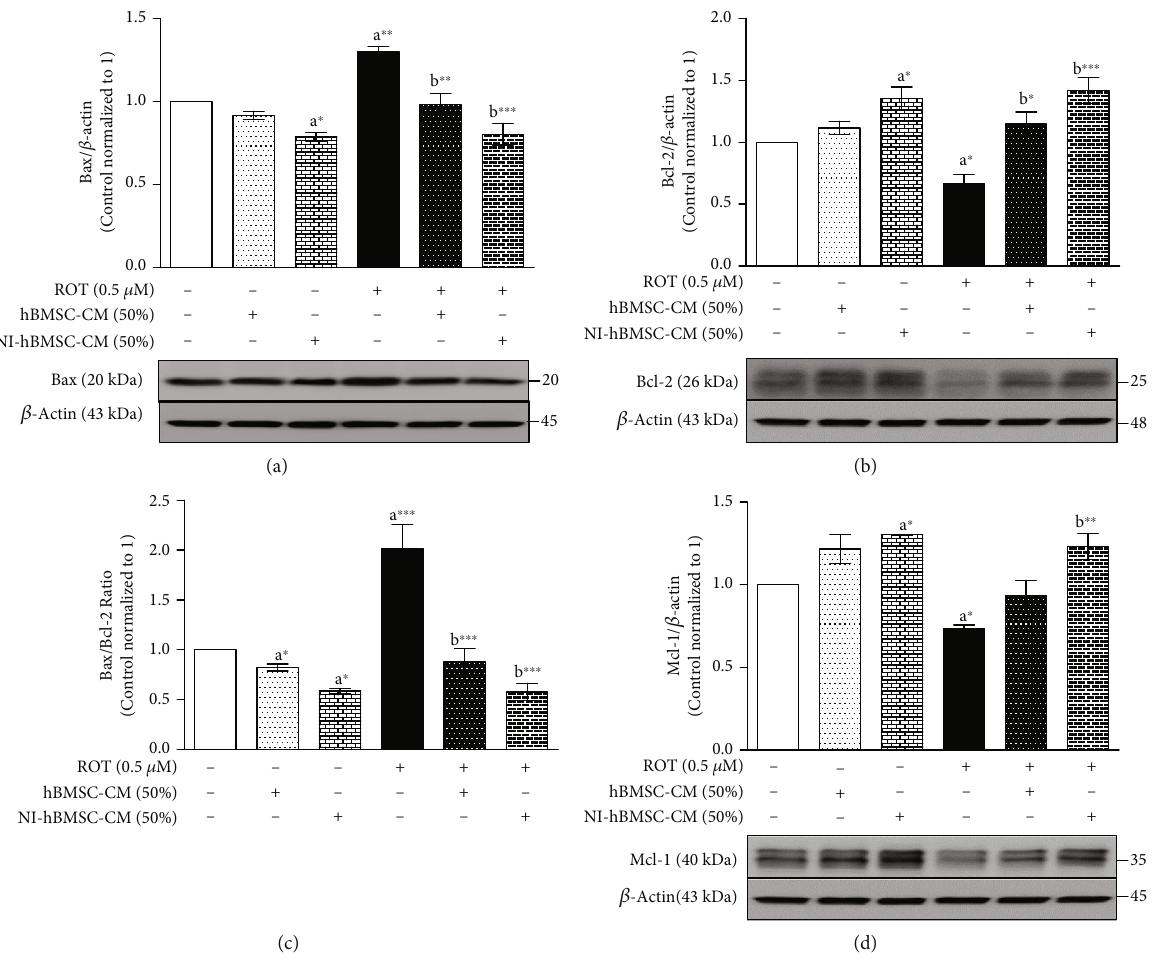
Figure 5: SH-SY5Y cells were seeded as 5 × 10 4 cells/mL of DMEM containing 1% FBS and used for experiments after overnight incubation. Cells with the absence or presence of ROT (0.5 μ M) for 48h were treated with hBMSC-CM (50%) or NI-hBMSC-CM (50%) during the last 24h and assessed for Bax (a), Bcl-2 (b), Bax/Bcl-2 ratio (c), Mcl-1 (d), and β -actin by Western blotting. Each picture is representative of three independent experiments. Data are the mean ± SEM of three independent experiments and analyzed by one-way analysis of variance (ANOVA) followed by Tukey ’ s post hoc test. Statistical signi fi cance: a compared with control; b compared with ROT; ∗ p < 0 : 05 , ∗∗ p < 0 : 01 , and ∗∗∗ p < 0 : 001